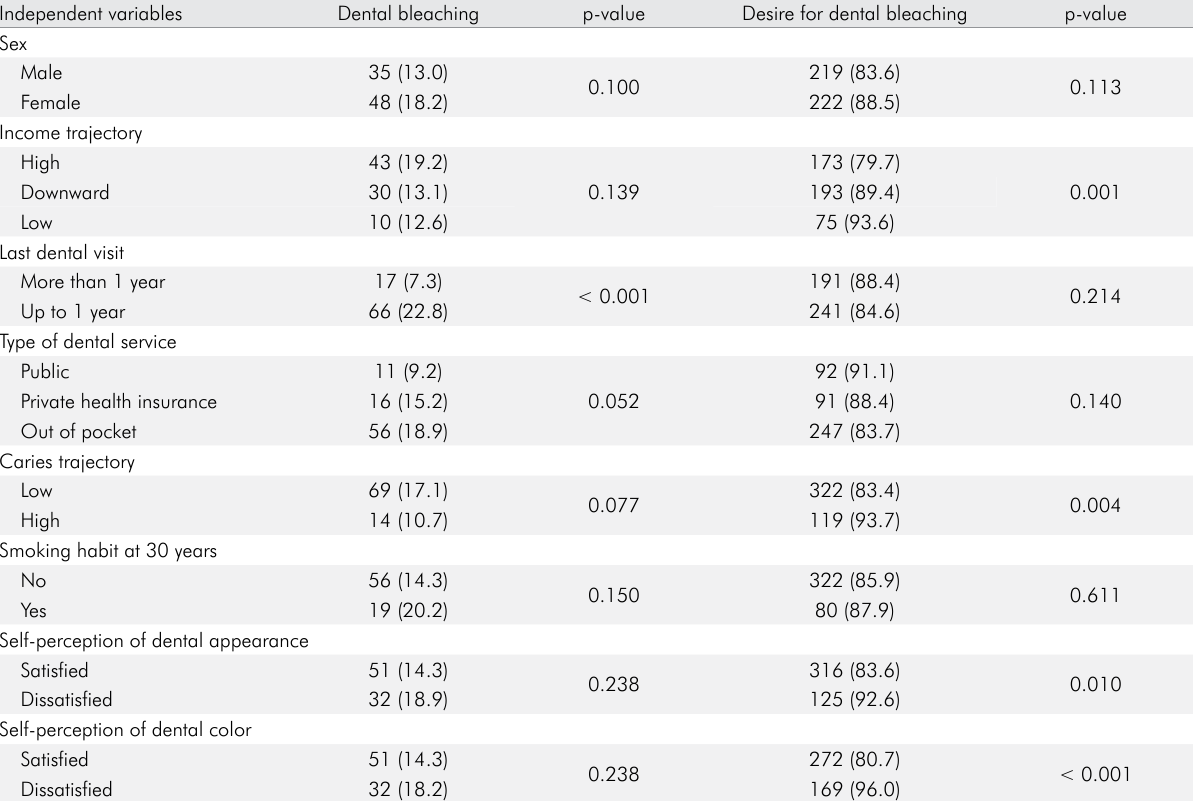
Table 1. Bivariate analysis of outcomes according to independent variables in adults from 1982 Pelotas birth cohort (n = 536). Independent variables Dental bleaching